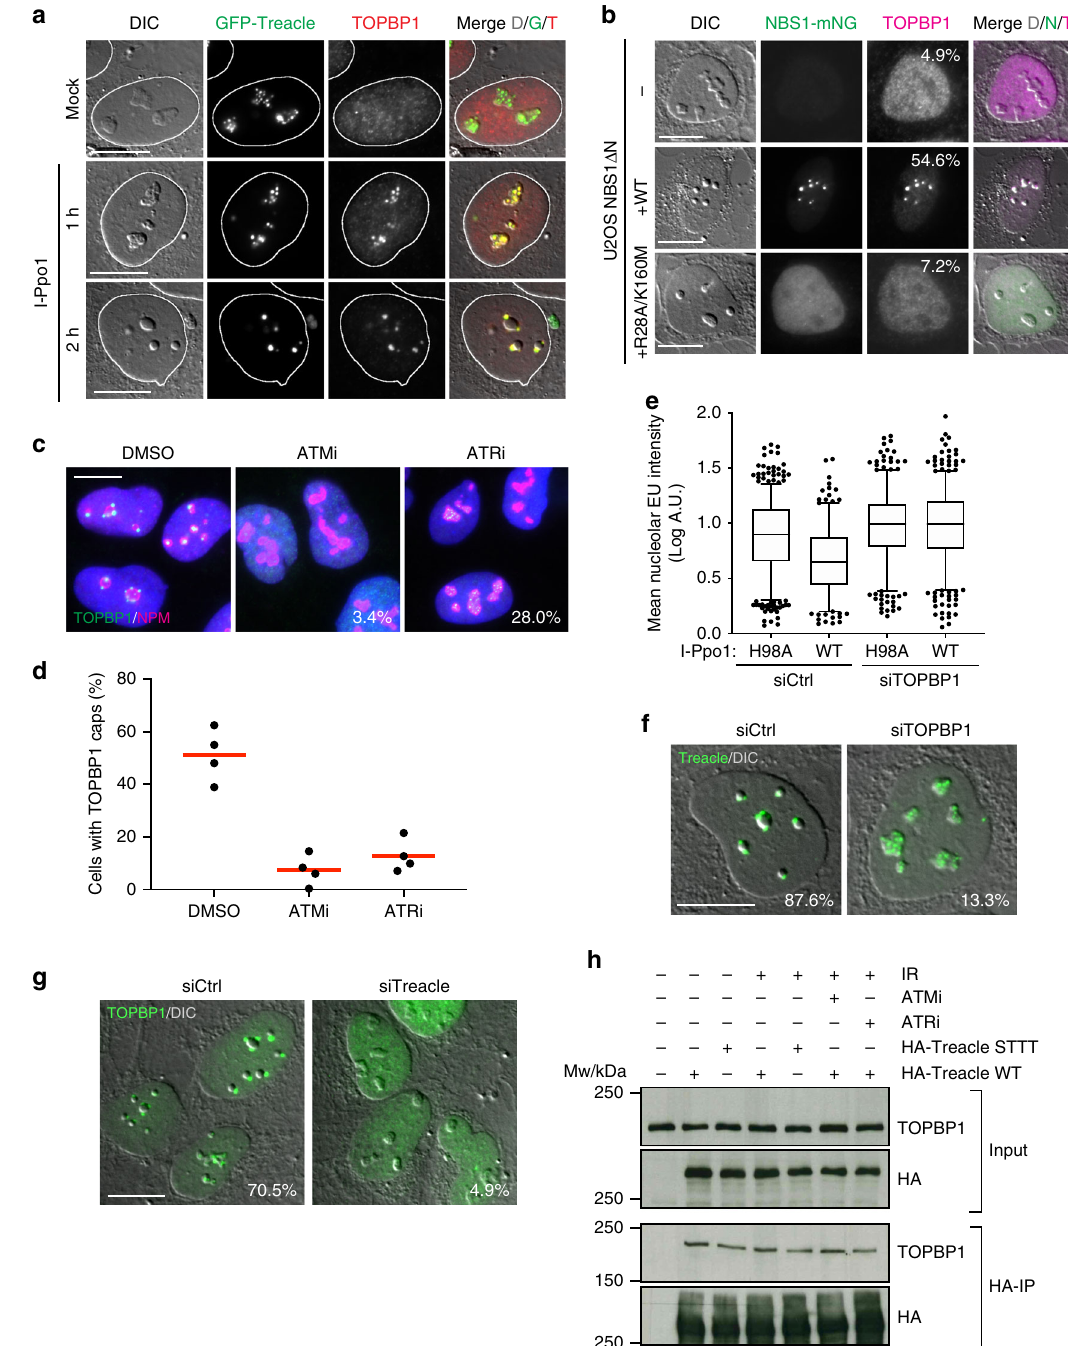
Fig. 4 TOPBP1 recruitment in response to rDNA breaks. a Timecourse of TOPBP1 localization in GFP-Treacle expressing U2OS cells after I-Ppo1 transfection. b TOPBP1 localization 2 h after I-Ppo1 transfection in NBS1 Δ N cells and NBS1 Δ N cells complemented with wild-type and mutant NBS1-mNG (percentage of cells with > 2 TOPBP1 caps are indicated; one of two experiments is shown). c TOPBP1 localization 2 h after I-Ppo1 transfection in ATMi- and ATRi-treated cells versus vehicle (DMSO)-treated cells (percentage of cells with TOPBP1 foci inside of the nucleoli are indicated; one of two experiments is shown). d Quanti fi cation of cells with TOPBP1 caps after ATMi and ATRi treatment versus vehicle (DMSO) treatment (red bars represent mean). e Quanti fi cation of nucleolar EU incorporation after I-Ppo1 H98A ( n = 692) and I-Ppo1 WT ( n = 649) transfection in control U2OS and after I-Ppo1 H98A ( n = 450) and I-Ppo1 WT ( n = 521) transfection in siTOPBP1-treated cells (boxes represent the median with 25 – 75 percentile range and whiskers represent the 5 – 95 percentile range. Data points outside of this range are shown individually). f Endogenous Treacle localization 2 h after I-Ppo1 transfection in control siRNA and TOPBP1 siRNA transfected cells (percentage of cells with > 2 Treacle caps are indicated; one of two experiments is shown). g TOPBP1 localization in Treacle-depleted U2OS cells and control cells 2 h after I-Ppo1 transfection (percentage of cells with > 2 TOPBP1 caps are indicated; one of two experiments is shown). h HA-immunoprecipitations from 293FT cells transfected with the indicated HA-tagged Treacle variants, in the presence or absence of ATMi and ATRi and with and without IR treatment as indicated. STTT mutated Treacle: S171A, T173A, T203A, T210A. All scalebars = 10 µ m. Source data are provided as a Source Data fi